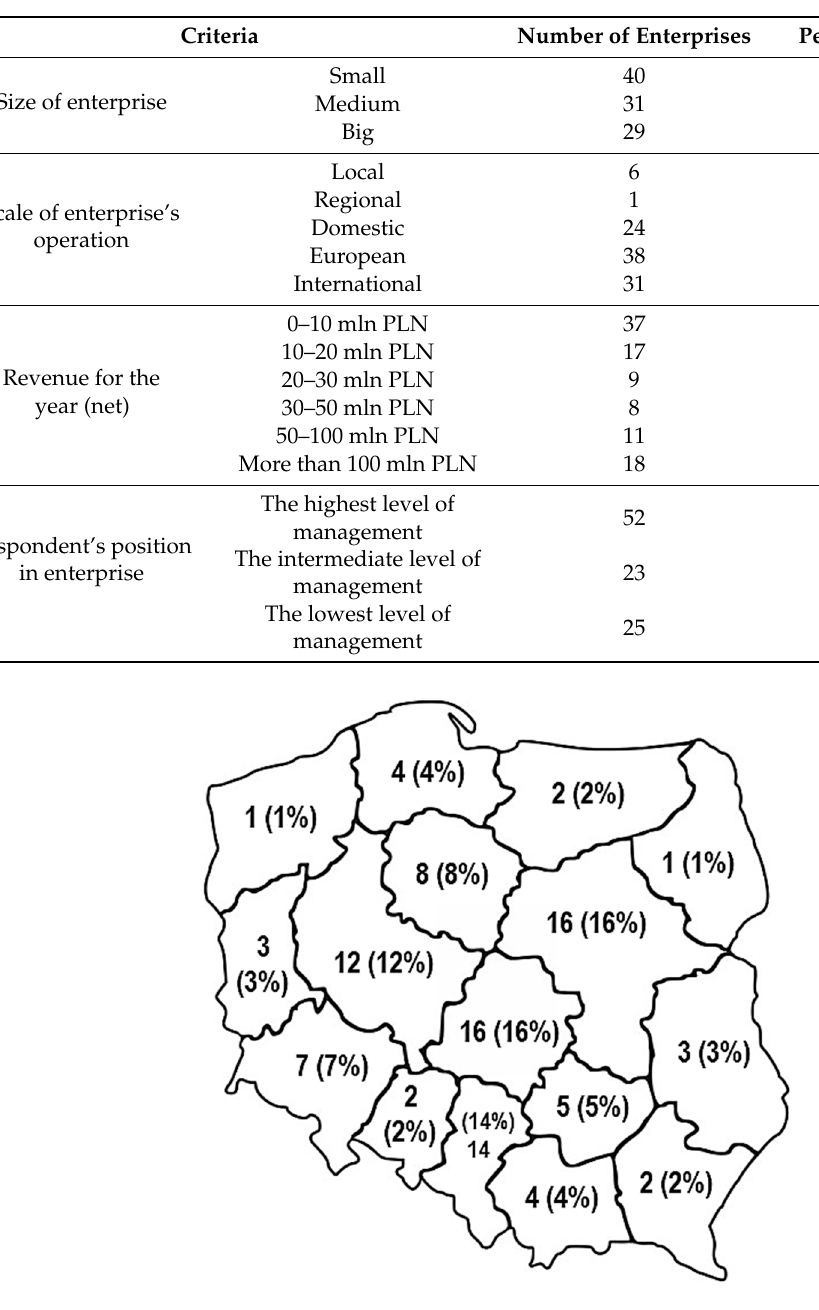
Figure 3. Number and percent share of surveyed enterprises in voivodships in Poland. Table 6. Criteria for description of the research sample (N = 100).